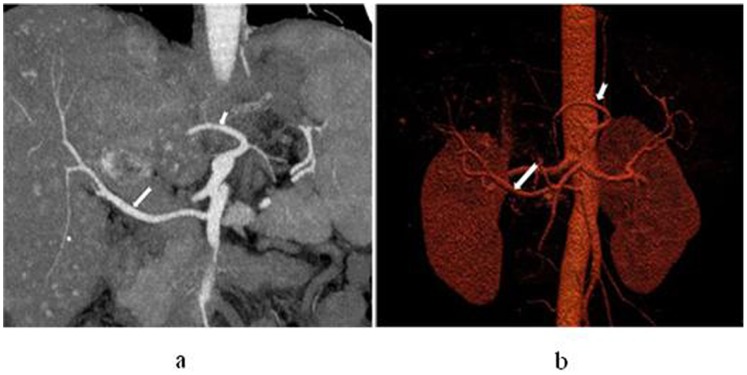
In a 37-year-old woman with hepatocellular carcinoma in right lobe of liver, the variable HA participates in blood supply for the carcinoma.Maximum intensity projection (a) and volume rendering technique (b) display that right HA arise from superior mesenteric artery (long arrow) and left HA arise from left gastric artery (short arrow), which give off branches into the lesion.